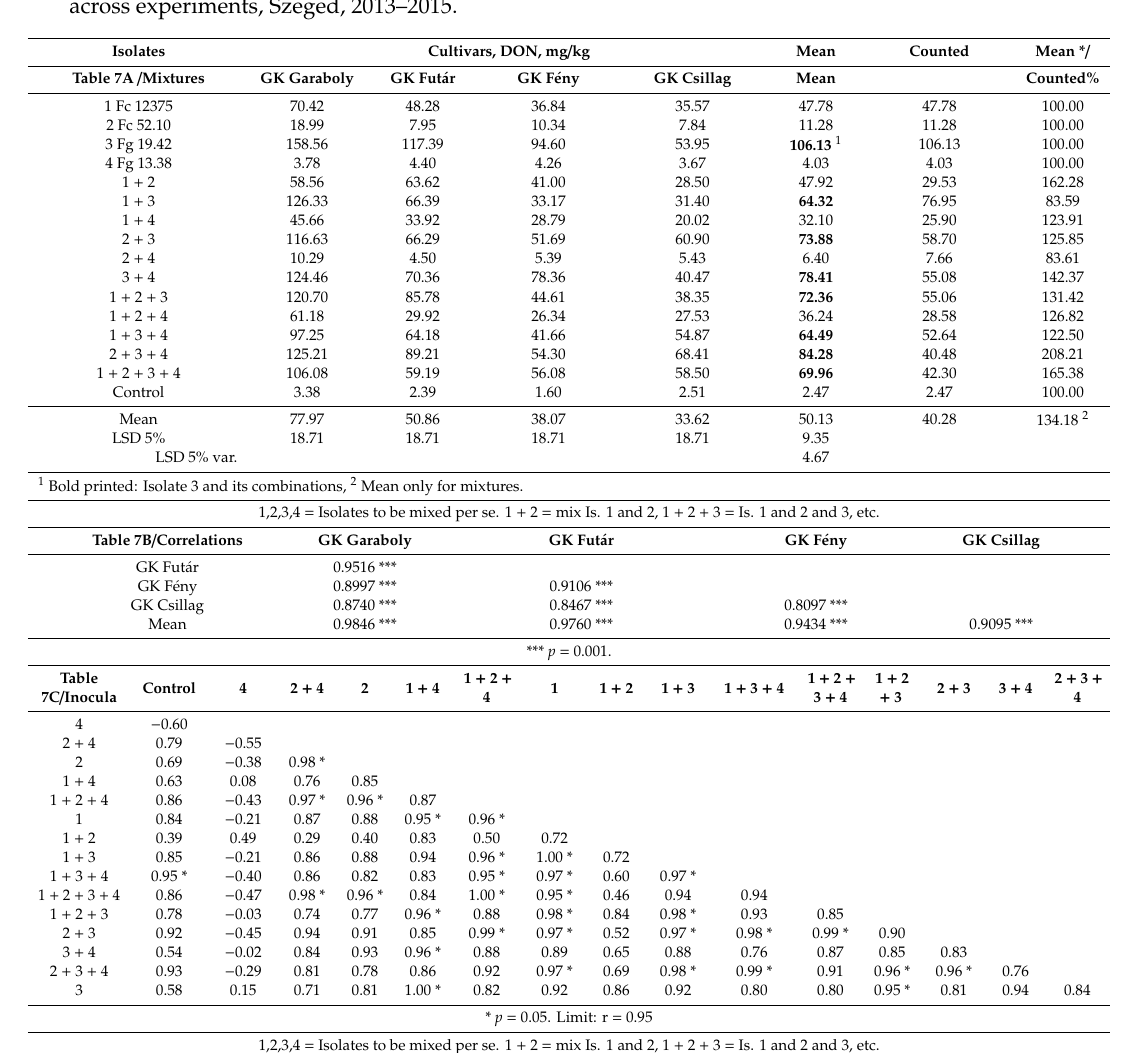
Table 7. Response of the wheat cultivars to the di ff erent isolates and their mixtures. DON data (mg / kg) across experiments, Szeged, 2013–2015. Isolates Counted Table 7A / Mixtures